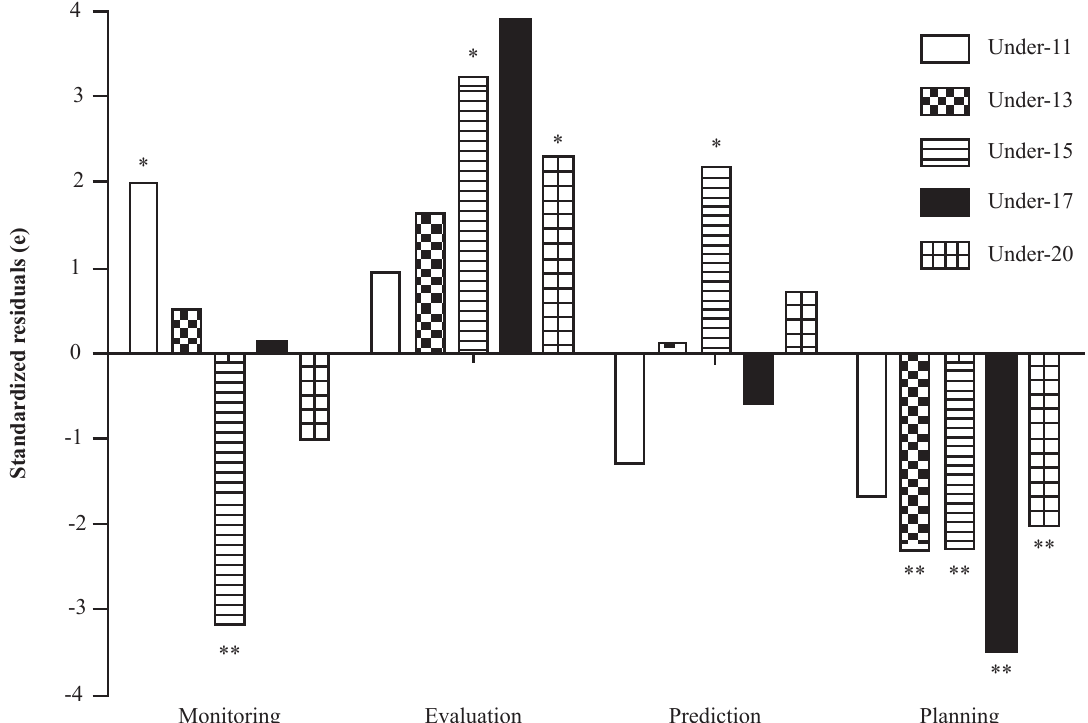
Figure 2. Standardized residuals (e) per statement type for each age level.* Significantly positive influence (e > 1.96); ** Significantly negative influence (e <